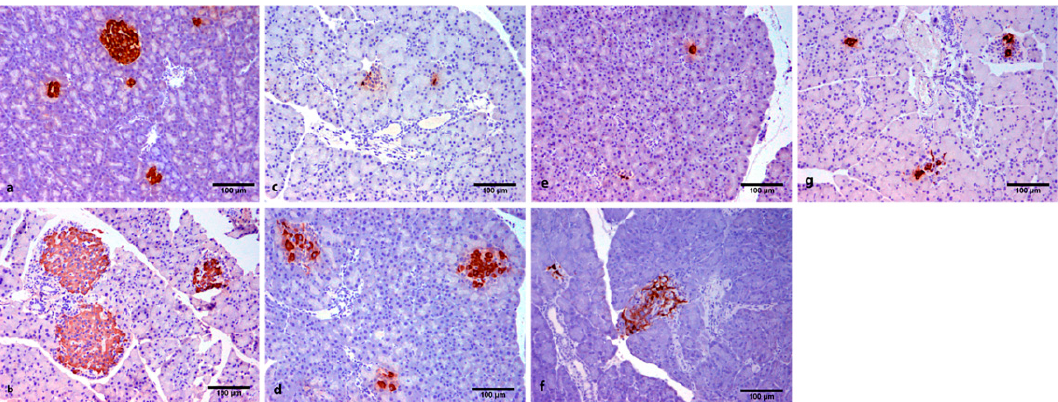
Figure 1. Pancreas histopathological examination and insulin immunohistochemistry from diabetic rats treated with C. papaya extract. ( a ) Normal control (NC) β -cells from normal islet with a greater content of insulin; ( b ) Normal rats that received 62 mg/Kg/day of CPLE (NC + CPLE62), large islets have greater insulin content when compared to NC; ( c ) Diabetic (D), β -cells from small islets have a significantly reduced insulin-positive area; ( d ) Diabetic rats that received 31 mg/Kg/day of CPLE (D + CPLE31), small islets have a greater density of insulin granules than β -cells from D; ( e ) Diabetic rats that received 62 mg/Kg/day of CPLE (D + CPLE62), showed a significant increase in positive insulin immunoreactive with respect to pancreas from D; ( f ) Diabetic rats that received 125 mg/Kg/day of CPLE (D + CPLE125), diffuse islet which has a low density of insulin granules; ( g ) Diabetic rats that received 5 IU/kg/day of insulin display islets with bigger insulin content.